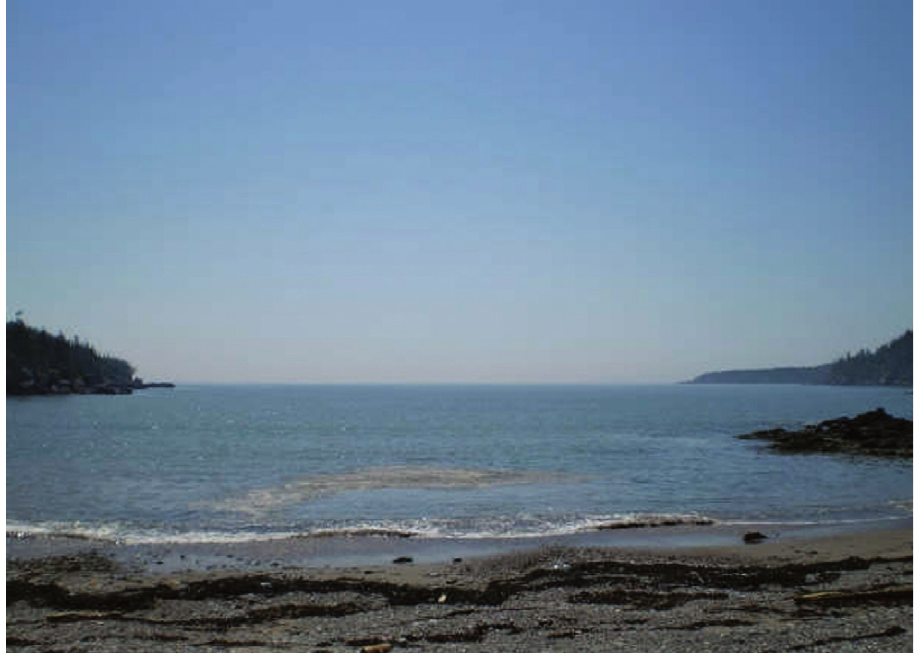
Fig. 13. Habitat of D. mersa and H. fl avipes (Chance Harbour, New Brunswick).